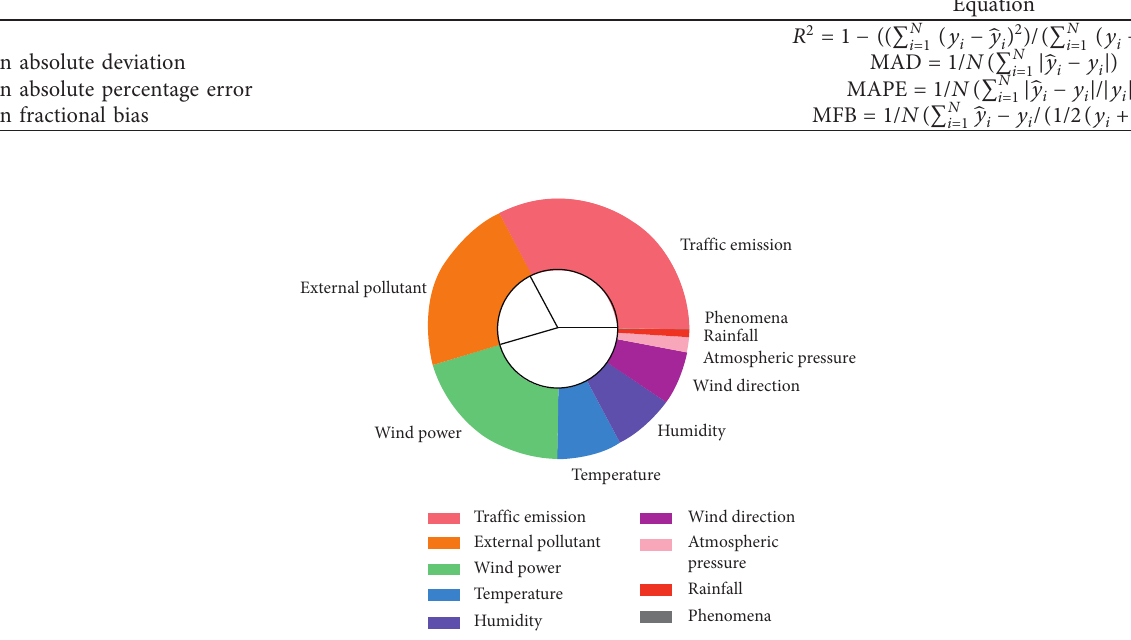
Figure 18: Feature importance for the